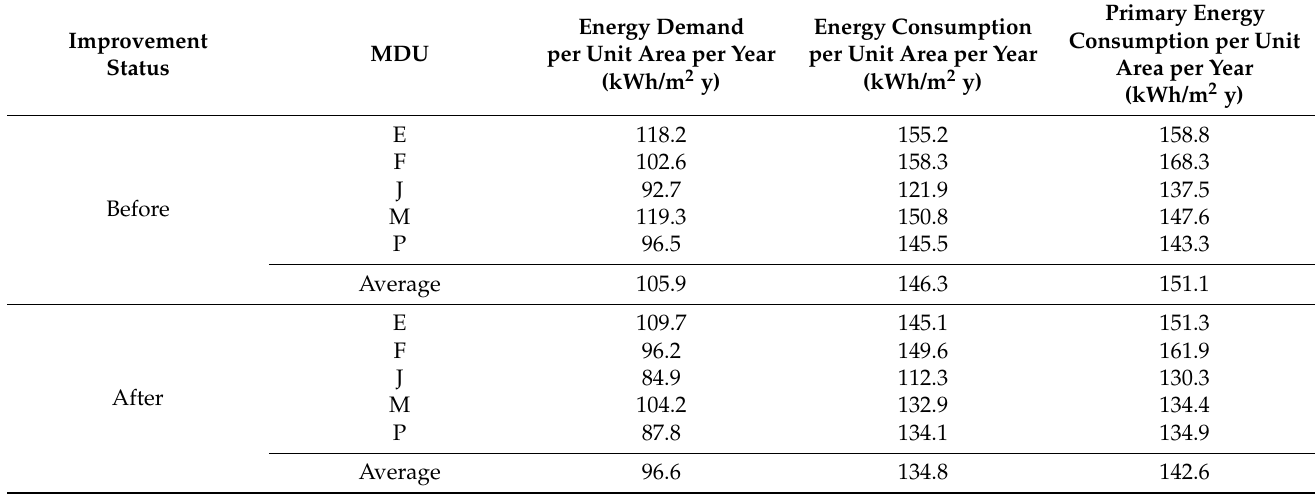
Table 5. Changes in energy demand and energy consumption of E, F, J, M, and P MDUs before and after window